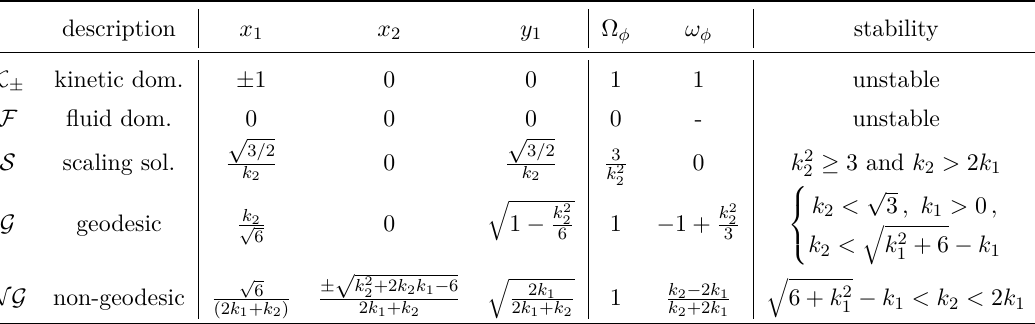
Table 1 . Instantaneous fixed points of the system with a pressureless barotropic fluid ω b = 0 and two scalar fields for k 0 . The stability region is given in the last 2 >